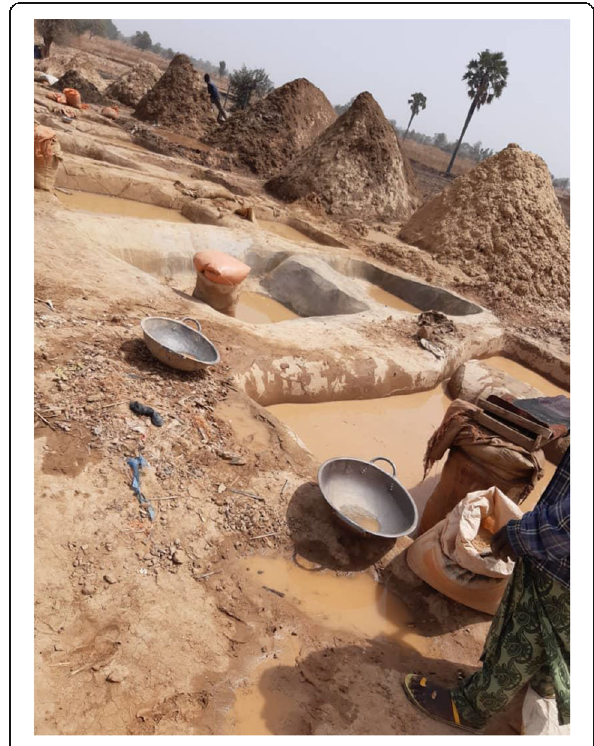
Fig. 4 Site 3 of the local mining area